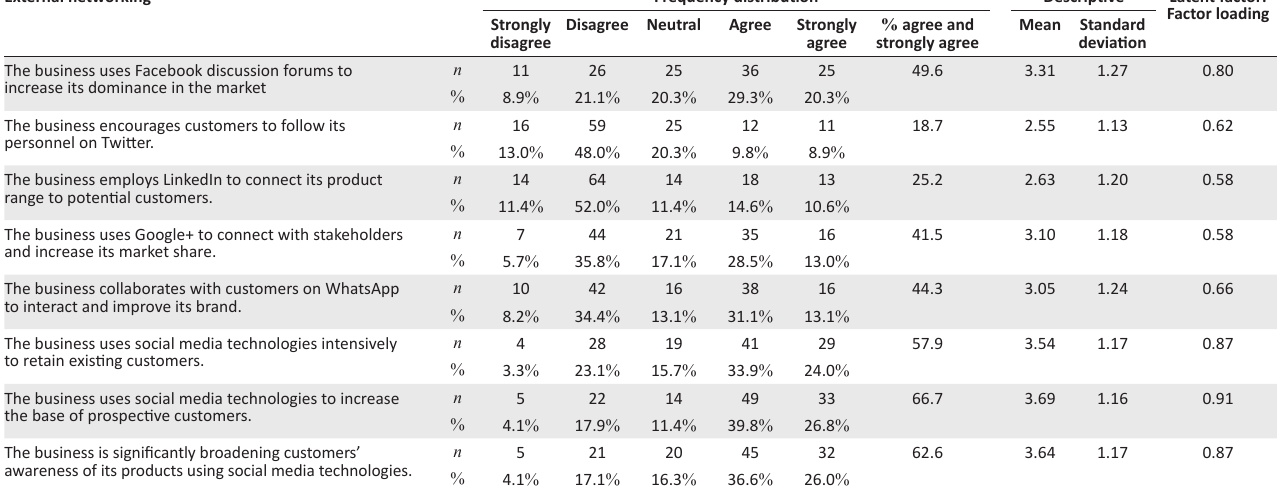
TABLE 4: External networking. External networking